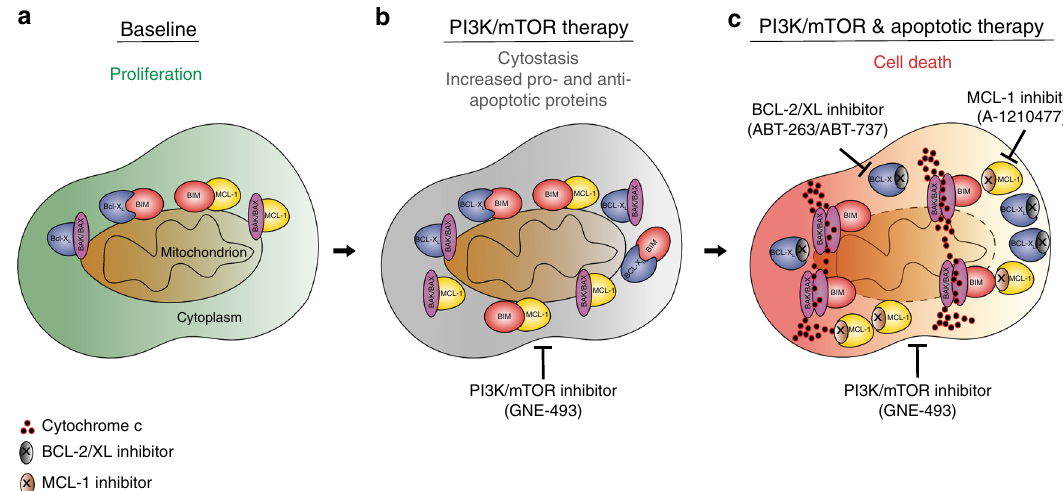
Fig. 7 PI3K/mTOR inhibition induces elevation of both pro-apoptotic and anti-apoptotic BCL-2 family proteins that present a therapeutic vulnerability in ovarian cancer cells. a At baseline cells express balanced levels of the pro-apoptotic proteins BIM, BAK, and BAX and the anti-apoptotic proteins BCL-X L and MCL-1. b Treatment with the PI3K/mTOR inhibitor results in cytostatic effects and minimal cell death due to upregulation of both pro-apoptotic and anti-apoptotic proteins that maintain a homeostatic apoptotic balance. c Combination treatment with an inhibitor targeting BCL-X L unleashes the elevated pro-apoptotic proteins and cell death induction ensues. In ovarian cancer cells that express high MCL-1 and low BCL-X L , co-treatment with a MCL-1 inhibitor is required to induce cell